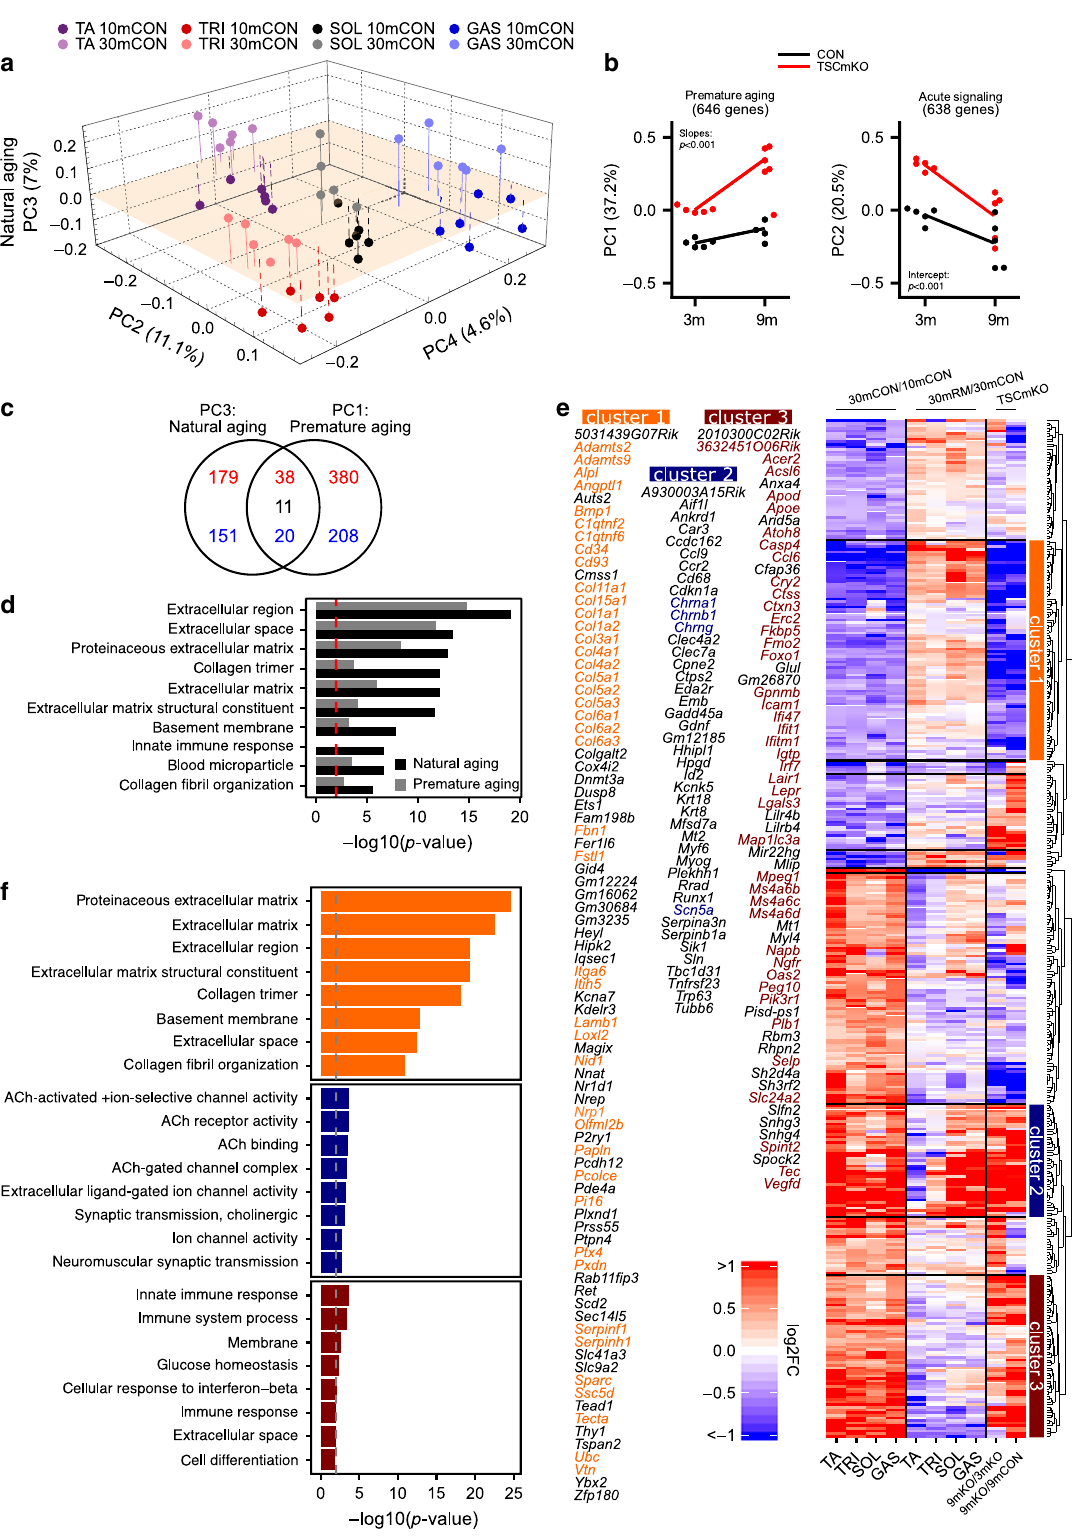
genes were signi fi cantly decreased, while cluster 2 and 3 genes were signi fi cantly increased in 30m compared to 10m muscle (Fig. 7c). Genes from clusters 2 and 3 also had increased expression in 30m xNMJ compared to 10m xNMJ regions, suggesting that age-related gene expression changes in these clusters were muscle-wide although expression was higher at the